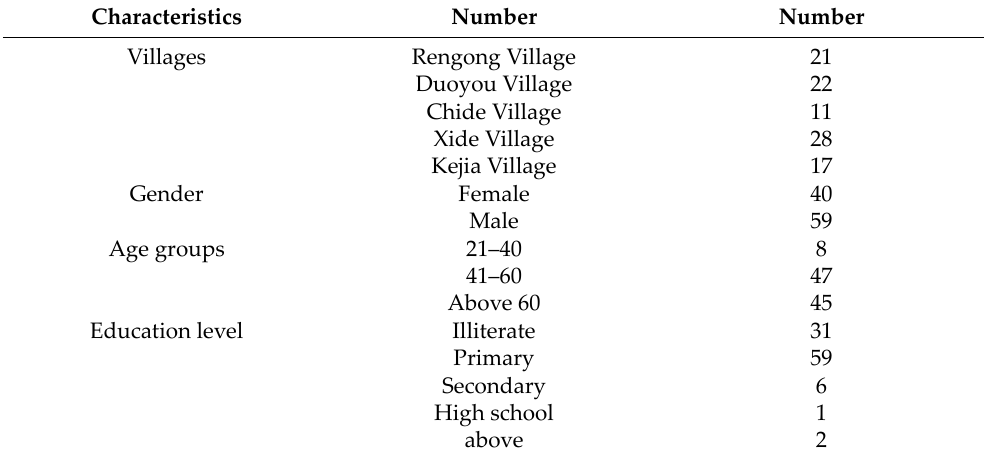
Table 1. Characteristics of